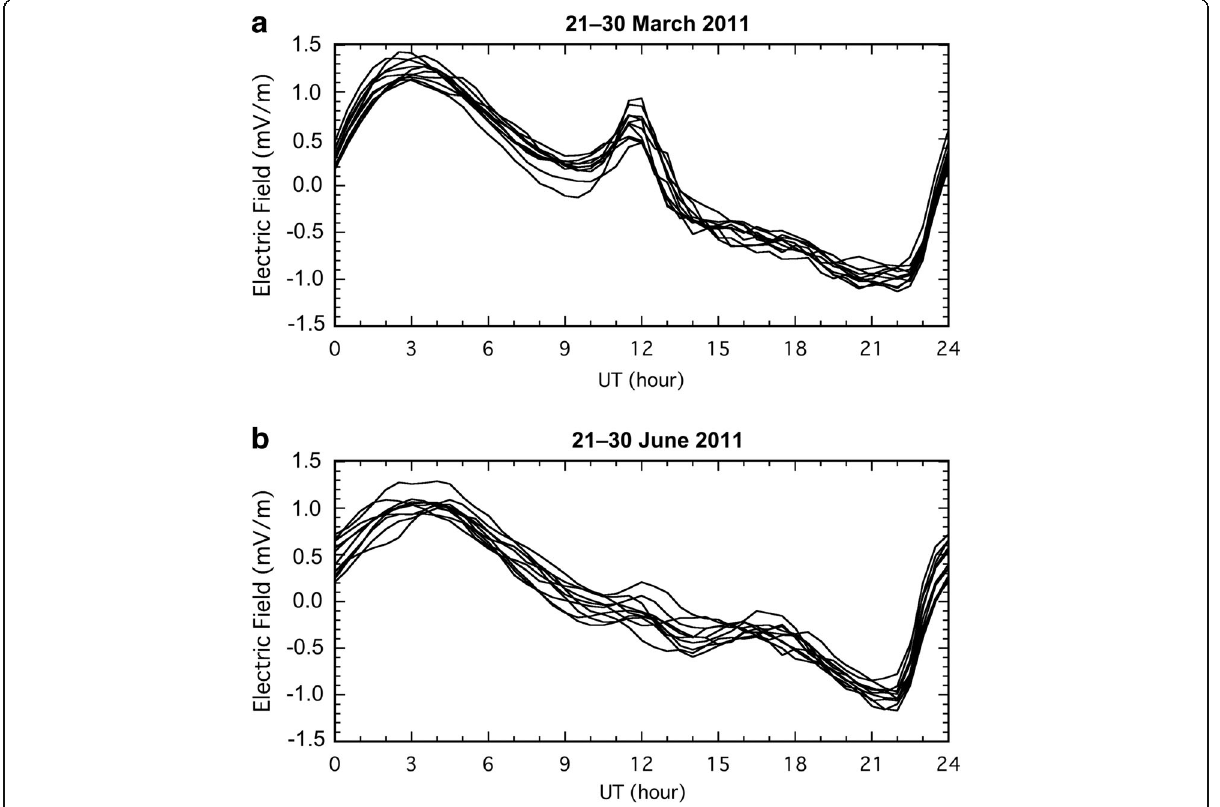
Fig. 7 Examples of the eastward electric field variations in GAIA. Day-to-day variations of the eastward electric field at the EAR site are shown a for 21 – 30 March, 2011 and b for 21 – 30 June 2011. The prereversal enhancement is clearly seen in March around 12 UT (i.e., 18 – 19 LT), while it is much smaller in